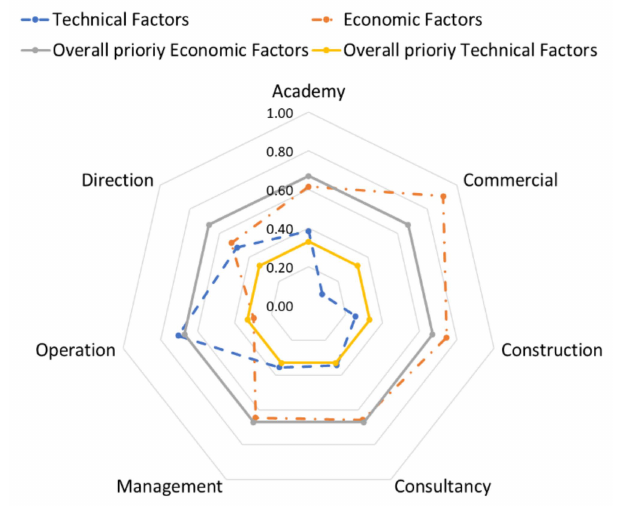
Figure 4. Importance weight of factors of every group of experts.